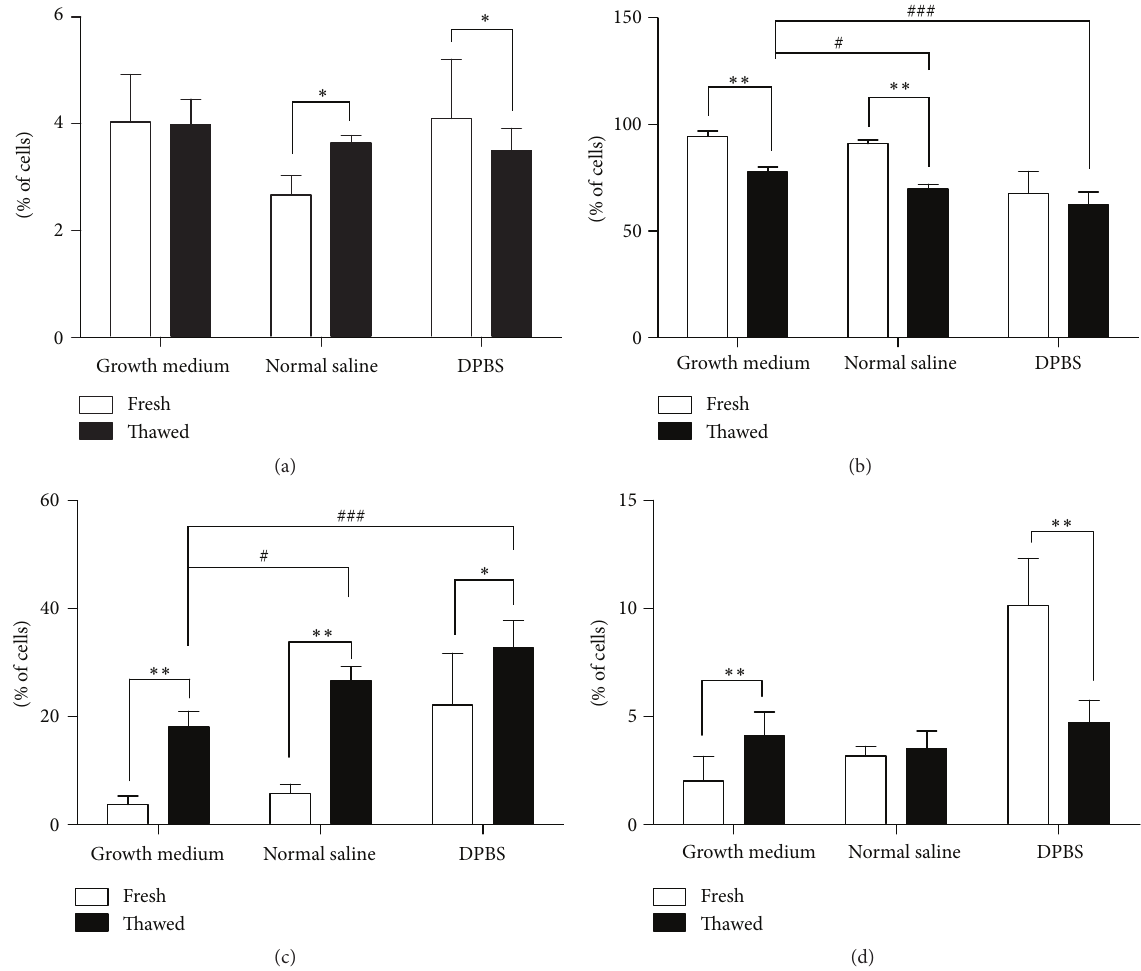
Figure 5: Effect of freeze-thawing procedure on cell clumping and viability of passage 5 rat BMMSCs. (a) Cell clumps or large cells > 30 𝜇 m; (b) viable cells; (c) dead cells; (d) apoptotic cells. ∗ 𝑃 < 0.05 , ∗∗ 𝑃 < 0.01 ; # 𝑃 < 0.05 , ### 𝑃 < 0.001